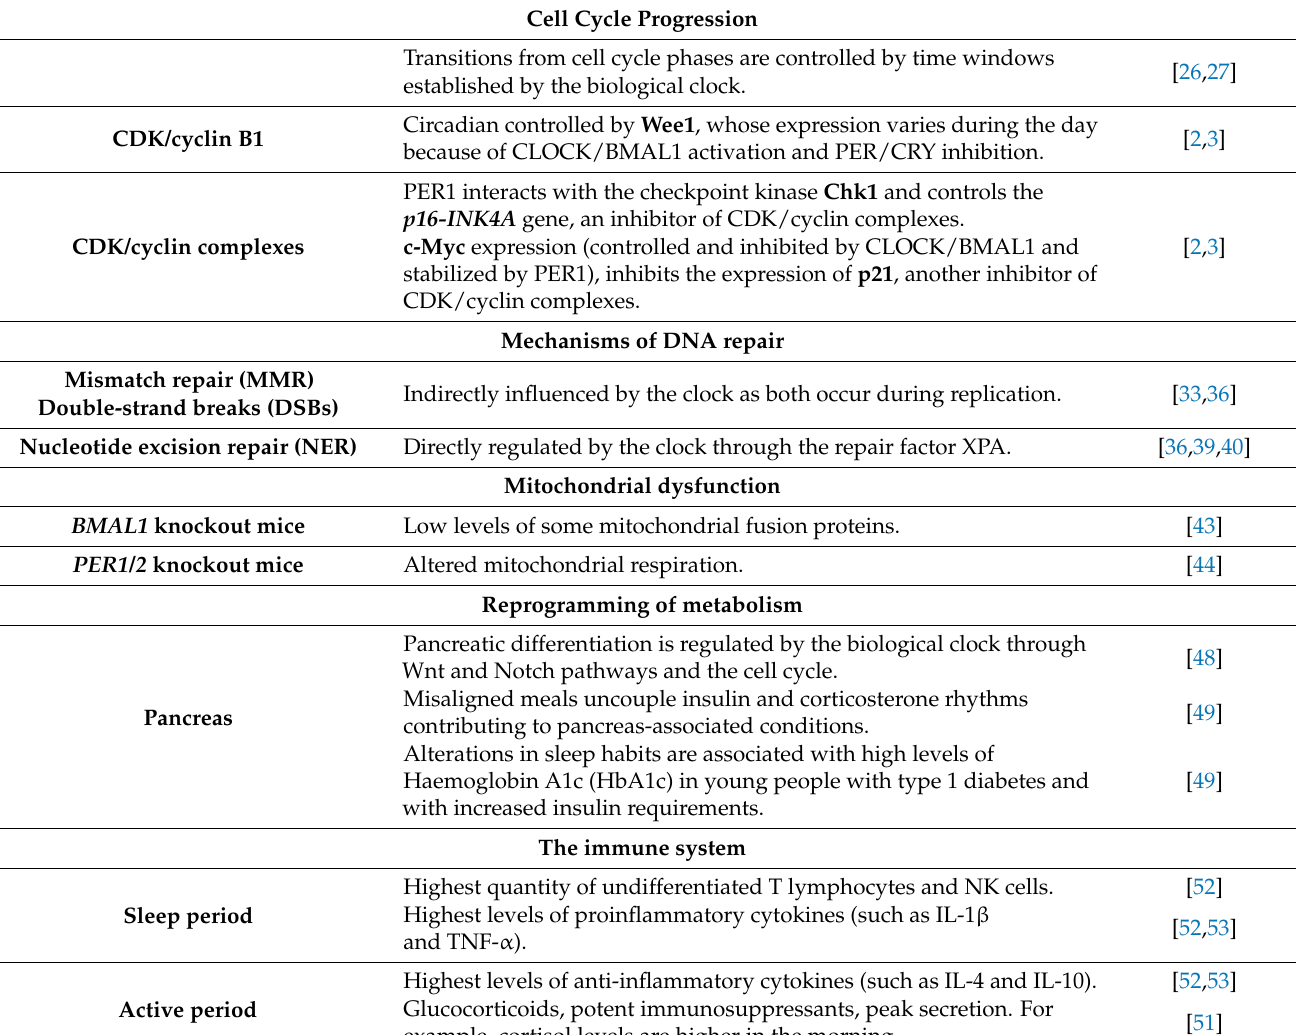
Table 1. Summary of the connections between circadian rhythms and cancer. Cell Cycle